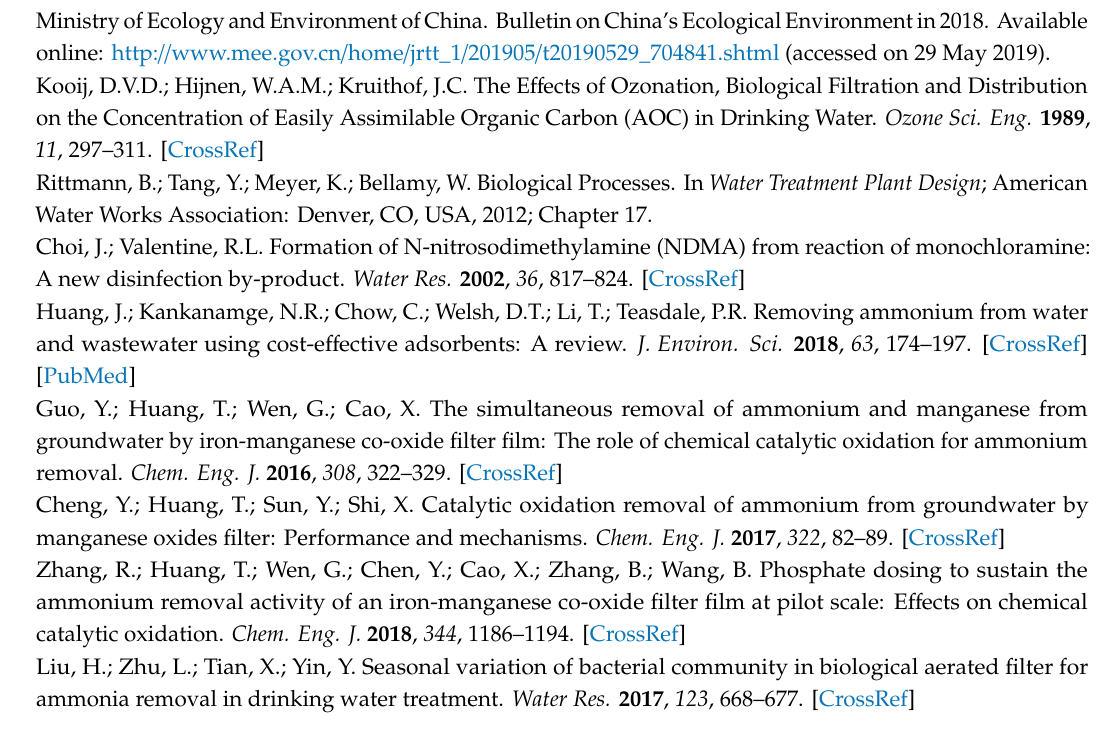
Figure S1: Dissolved oxygen (DO) concentration depth profiles (aeration from the bottom of the filter bed) with di ff erent intensities of aeration, Figure S2: The DO concentration depth profiles with aeration at 1 / 3 of the height of the filter bed, Figure S3: Ammonium removal e ffi ciency with aeration using ozone, Table S1: The specific surface area of the MeO x coated sand, Table S2: Concentration of NH 4 + and NO 3- in aeration with air, pure oxygen and